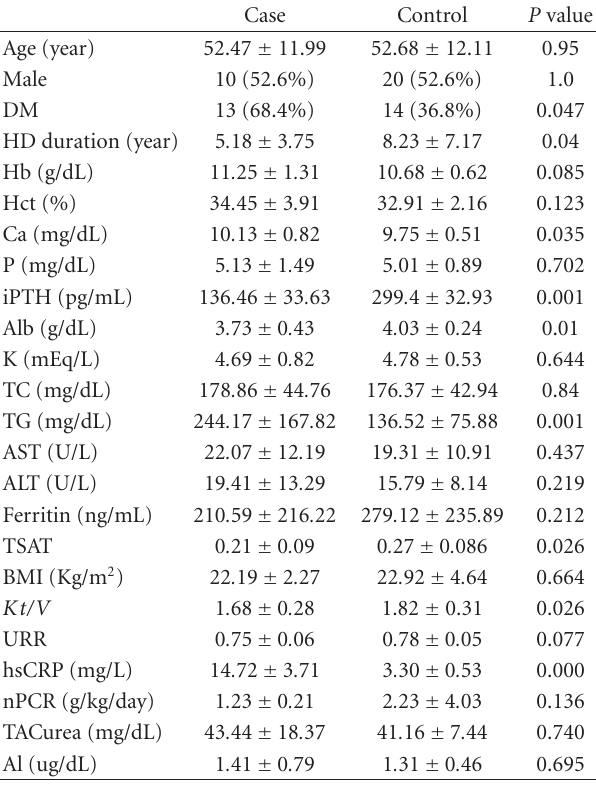
Table 1: Patients’ main demographic and laboratory data.